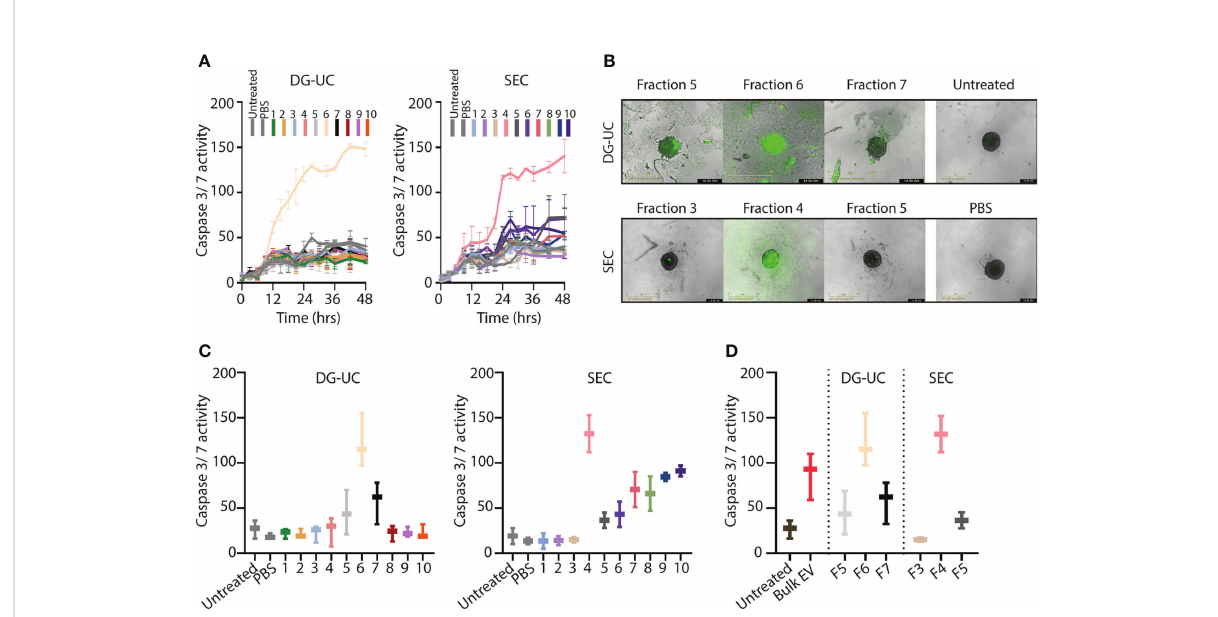
FIGURE 2 Separation of a subpopulation of NK-EVs that induce apoptosis of HCT-116 tumor spheroids. (A) Live monitoring of apoptosis induction via IncuCyte by 20 µg NK-EVs from either DG-UC or SEC fractions measured every third hour for 48 hrs. Apoptosis was detected with Caspase 3/7 green detection reagent. Data represents 3 independent experiments ±SEM (B) Representative images of HCT-116 tumor spheroids 24 hrs after application of either DG-UC fractions 5-7 or SEC fractions 3-5 imaged by IncuCyte. PBS (in same volume as EVs) or medium alone (untreated) served as negative controls. (C) Comparison of apoptosis exerted by 20 µg NK-EVs from DG-UC or SEC fractions after 24 hrs. Data represents 3 independent experiments ±SEM. (D) Comparison of apoptosis mediated by 20 µg for either bulk EVs or DG-UC fractions 5-7 or SEC fractions 3- 5 after 24 hrs as measured by IncuCyte. Data are presented as mean ±SEM of three separate